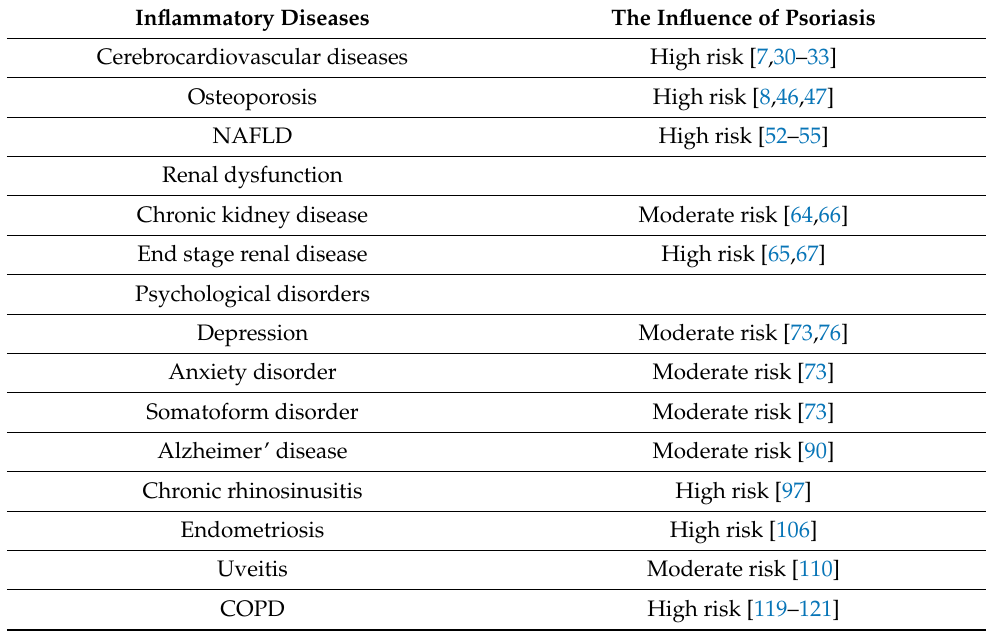
Table 1. The clinical evidence of psoriasis and other inflammatory